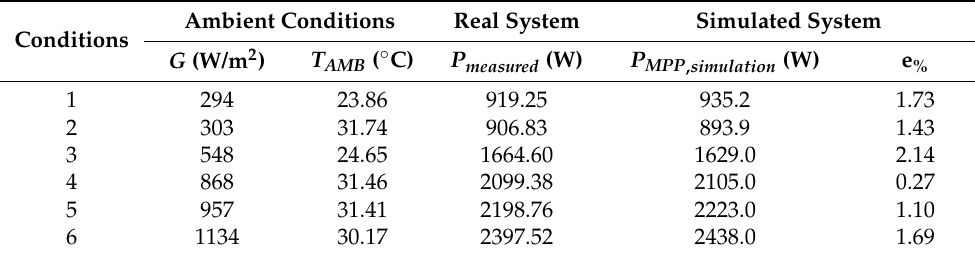
Table 7. Output power in the real PV system and the MPP of the modeled PV system.